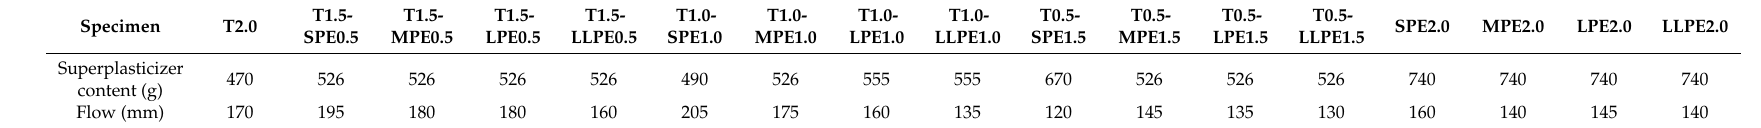
Table 3. Contents of superplasticizer and measured flow values of UHPFRCC mixtures.